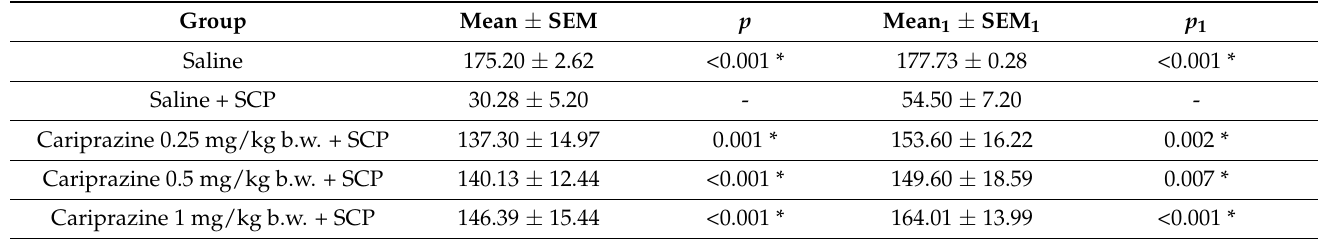
Table 2. Training latency values (in seconds) in step-through passive avoidance